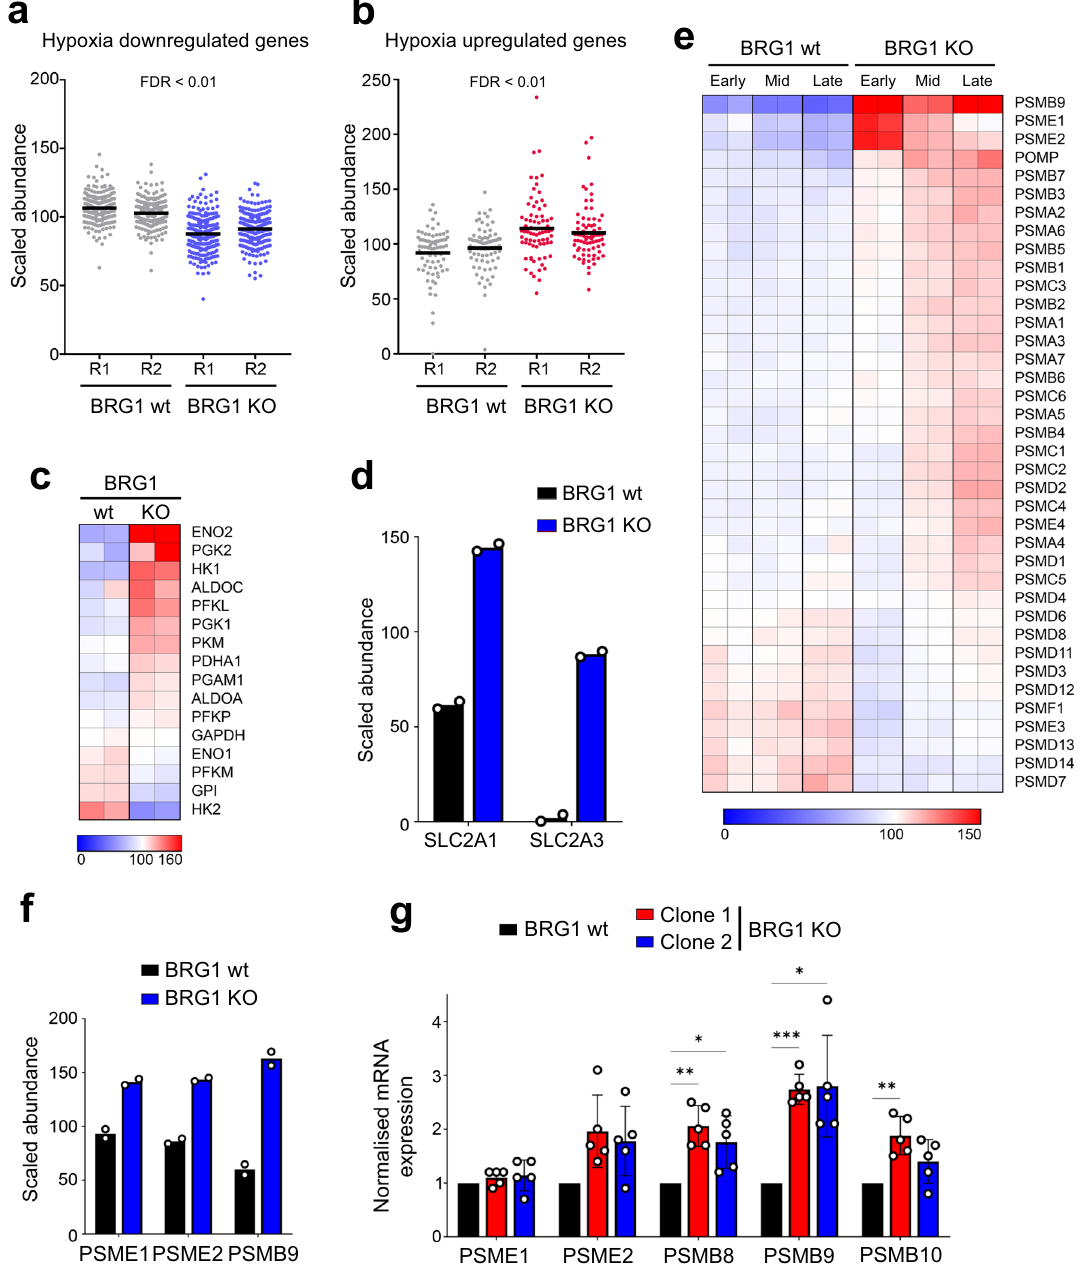
Fig. 5 BRG1-de fi cient cells show changes in pathways associated with tolerance to aneuploidy at early time points. a Scaled abundance of hypoxia proteins with a downregulation trend (GSEA gene list MANALO_HYPOXIA_DOWN) by proteome analysis in HCT116 and BRG1 knockout (KO) cells at early time points. Duplicates are represented as R1 and R2. b Scaled abundance of hypoxia proteins with upregulation trend (GSEA gene list MANALO_HYPOXIA_UP) by proteome analysis in HCT116 and BRG1 KO cells at early time points. Duplicates are represented as R1 and R2. c Heatmap showing a scaled abundance of glycolysis proteins in HCT116 and BRG1 KO cells at early time points. Duplicates are shown side by side. The colour key indicates the relative abundance of each protein (scale: 0 – 160). d Scaled abundance of SLC2A1 and SLC2A3 glucose importers by proteome analysis in HCT116 and BRG1-de fi cient cells at early time points. Data were presented as the mean; n = 2. e Heatmap showing scaled abundance of proteasome proteins in HCT116 and BRG1-de fi cient (KO) cells at early, mid and late time points. Duplicates are shown side by side. The colour key indicates the relative abundance of each protein (scale: 0 – 150). f Scaled abundance of immunoproteasome subunits by proteome analysis in HCT116 and BRG1-de fi cient (KO) cells at early time points. Data were presented as the mean; n = 2. g mRNA expression of immunoproteasome subunits in HCT116 and two BRG1-de fi cient (KO) clones by RT-PCR analysis. The values have been normalised to GAPDH expression. Data were presented as the mean ± SD; n = 5. The p value was calculated with two-way ANOVA-Dunnett. * p < 0.05, ** p < 0.01 and *** p <